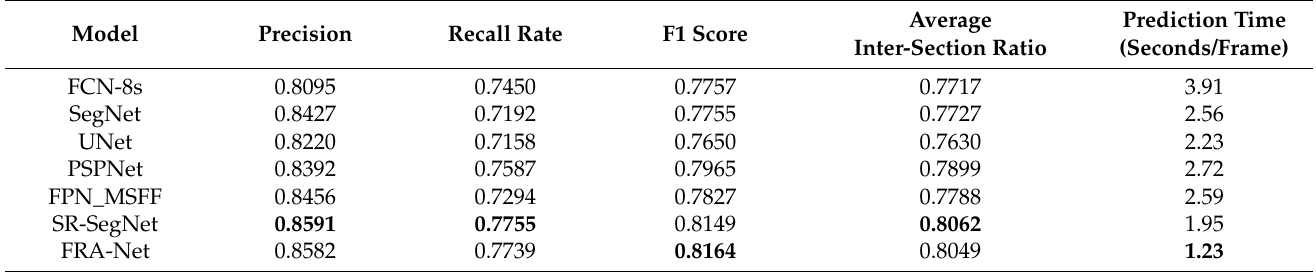
Table 4. Evaluation results of different methods in the Massachusetts building test